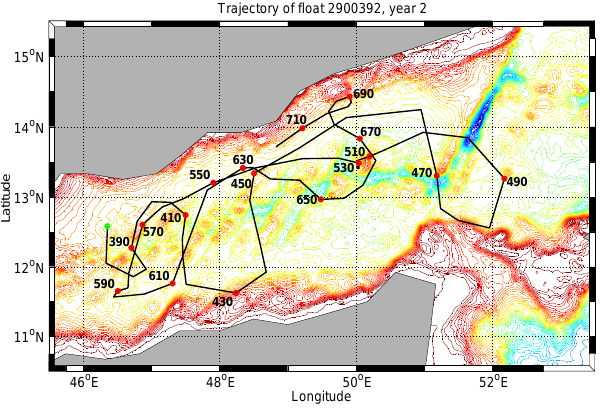
Fig. 10. Trajectory of float 2900392 in the Gulf of Aden, superim- posed on bathymetry, year 2; the green dot is the starting point of Figure 10: Trajectory of float 2900392 in the Gulf of Aden, superimposed on bathymetry, year 2; the green dot is the starting point of the trajectory; positions the trajectory; positions every 20 days are indicated by a red every 20 days are indicated by a red dot.